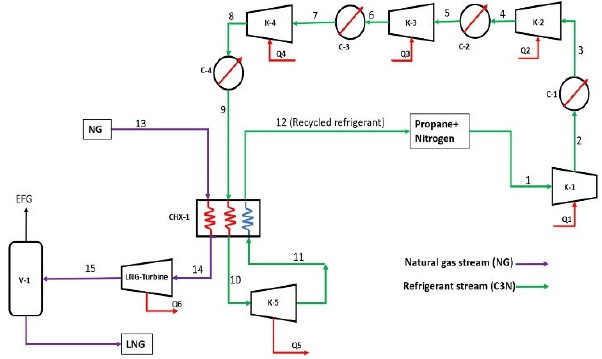
Figure 26. The variation of C p and C p /C v in different mole fractions of methane in the mixed refrigerant at standard conditions [92].